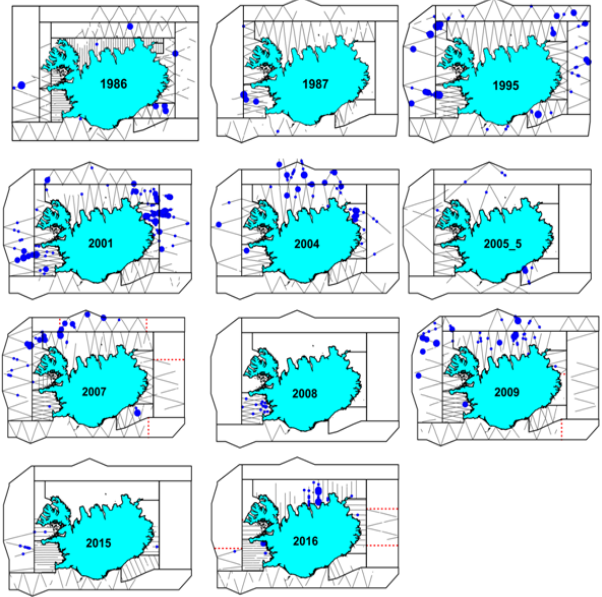
Figure 5. Realized survey effort and sightings of humpback whales by survey. Survey month is appended to year (numerical) if not June or July. No humpback whales were seen in surveys conducted in 1988, 2003_9, 2004_4, and 2004_9. Symbol sized varies with group size from 1 to 3. Post-stratification borders are shown as red dotted